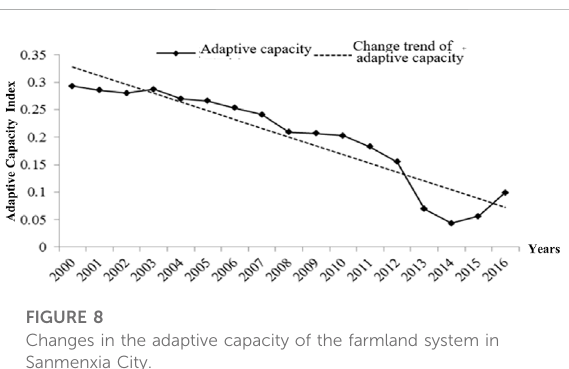
FIGURE 8 Changes in the adaptive capacity of the farmland system in Sanmenxia